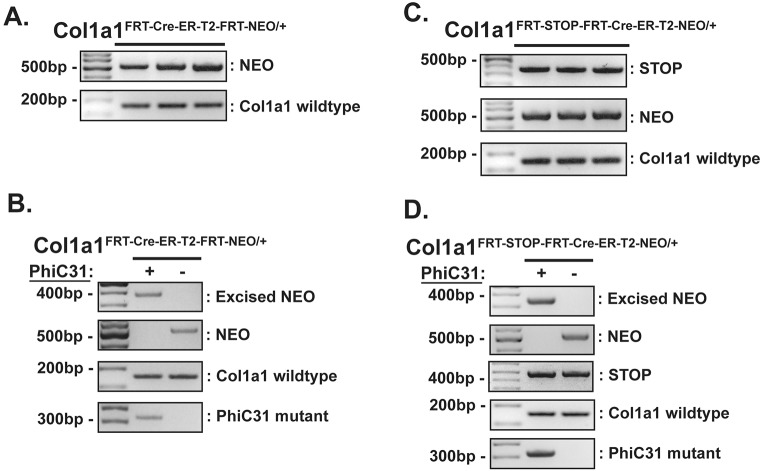
Germline transmission, and successful PhiC- and FlpO-mediated recombination of attB/attP and FRT sites. (A) PCR of tail DNA for the neomycin cassette of the Col1a1FRT-Cre-ER-T2-FRT-NEO and wild-type Col1a1 locus indicate germline transmission of a single copy of the Col1a1FRT-Cre-ER-T2-FRT-NEOallele. (B) PCR for the recombined neomycin cassette (excised NEO), unrecombined neomycin cassette (NEO), wild-type Col1a1 locus and mutant PhiC31 allele indicate successful PhiC31-mediated deletion of the neomycin selection cassette in the Col1a1FRT-Cre-ER-T2-FRT-NEO allele, generating the Col1a1FRT-Cre-ER-T2-FRT allele. (C) PCR of tail DNA for the neomycin cassette of the Col1a1FRT-STOP-FRT-Cre-ER-T2-NEO and wild-type Col1a1 locus indicate germline transmission of a single copy of the Col1a1FRT-STOP-FRT-Cre-ER-T2-NEO allele. (D) PCR for the recombined neomycin cassette (excised NEO), unrecombined neomycin cassette (NEO), presence of STOP cassette, wild-type Col1a1 locus and mutant PhiC31 allele indicate successful PhiC31-mediated deletion of the neomycin selection cassette in the Col1a1FRT-STOP-FRT-Cre-ER-T2-NEO allele, generating the Col1a1FRT-STOP-FRT-Cre-ER-T2 allele. Note that the amplified PCR product of the excised NEO band for the Col1a1FRT-Cre-ER-T2-FRTallele is slightly larger than that of the Col1a1FRT-STOP-FRT-Cre-ER-T2 allele owing to the presence of the FRT site in between the FWD1 and REV1 primers (see Fig. 2 for schematics with the location of the FRT sites relative to the primers).